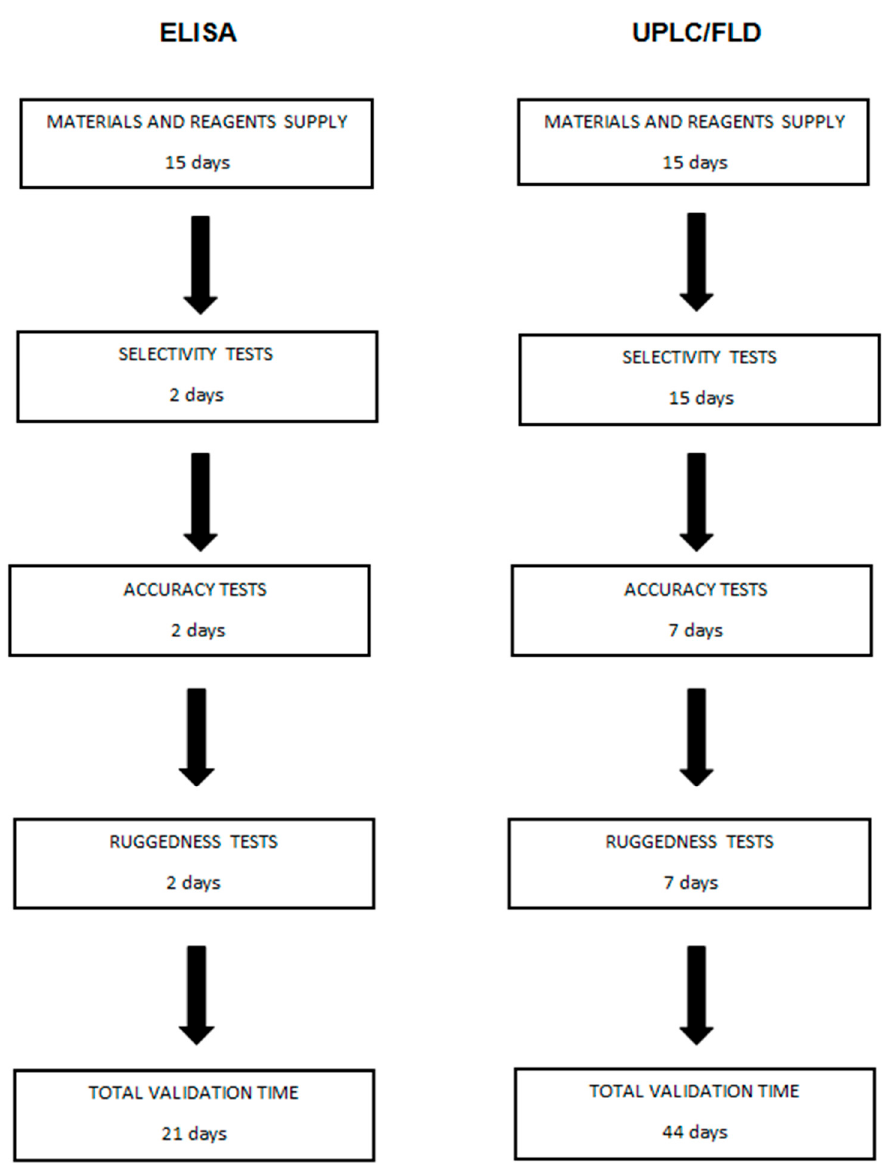
Figure 1. Validation procedure of ELISA and ultra performance liquid chromatography with fluorescence detection (UPLC/FLD) methods: step-by-step optimized workflow.